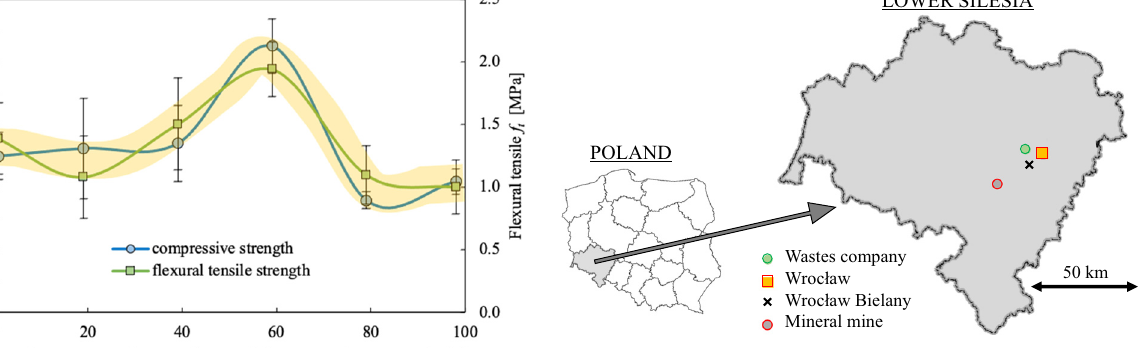
Figure 8: Comparison of the test results.